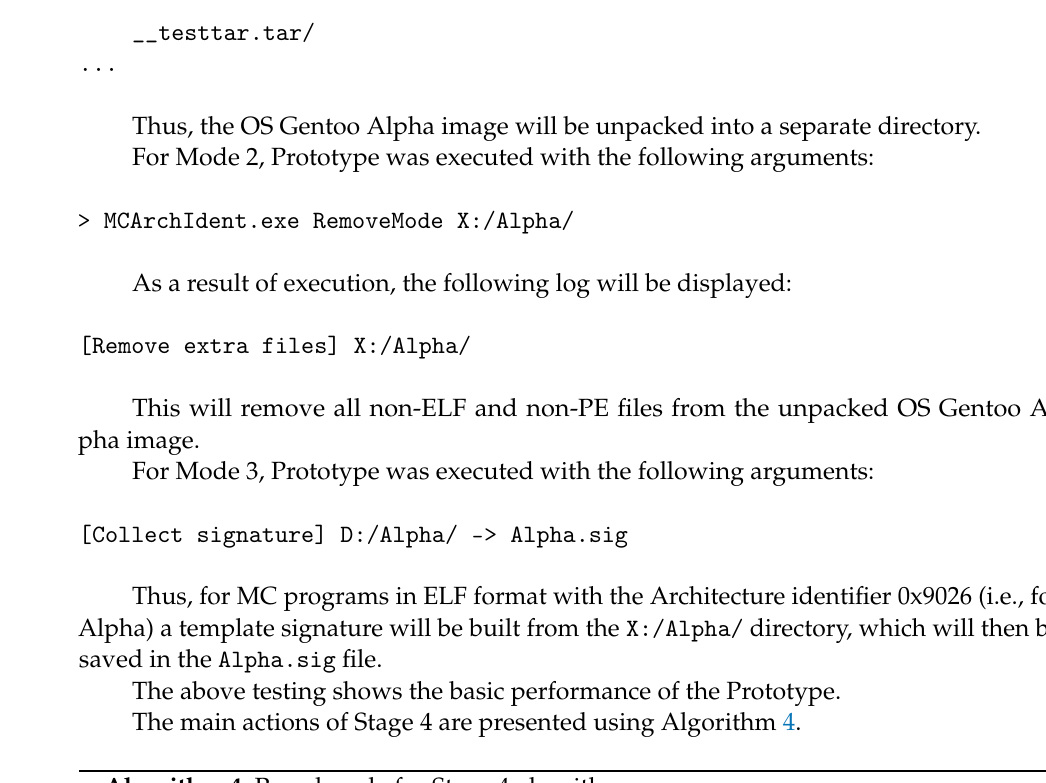
Algorithm 4: Pseudocode for Stage 4